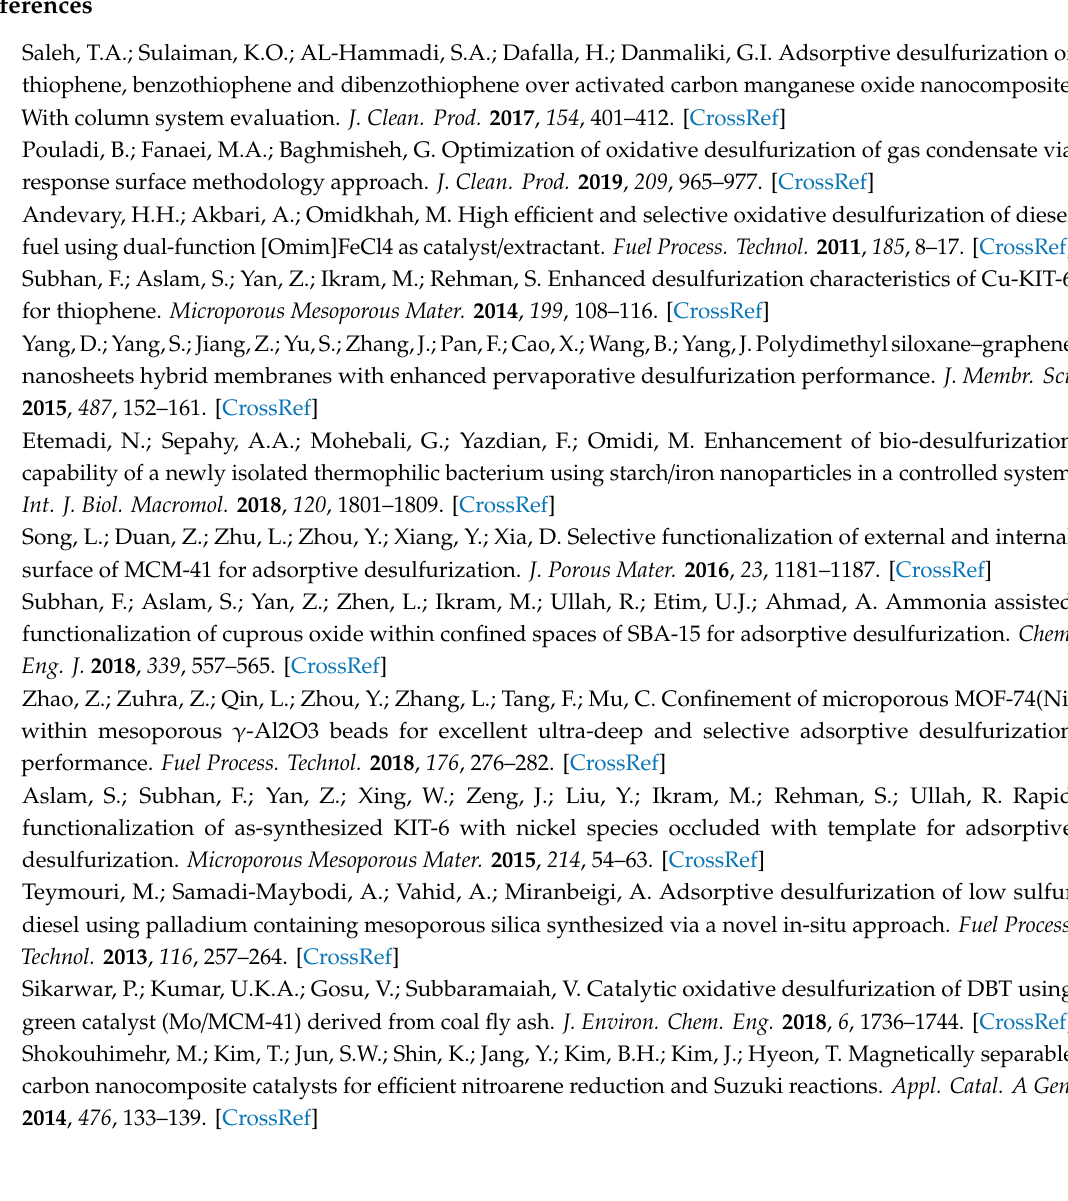
Figure S3: Langmuir model fitting for sulfur adsorption results over AgNO 3 / MCM-41 M material at di ff erent temperatures, Table S1: Sulfur compound distribution in a straight run diesel oil sample (Hua et al., 2003), Table S2: Critical diameter data for the main aromatic organosulfurs in real diesel, Table S3: Sulfur adsorption performance of some materials studied in literature for